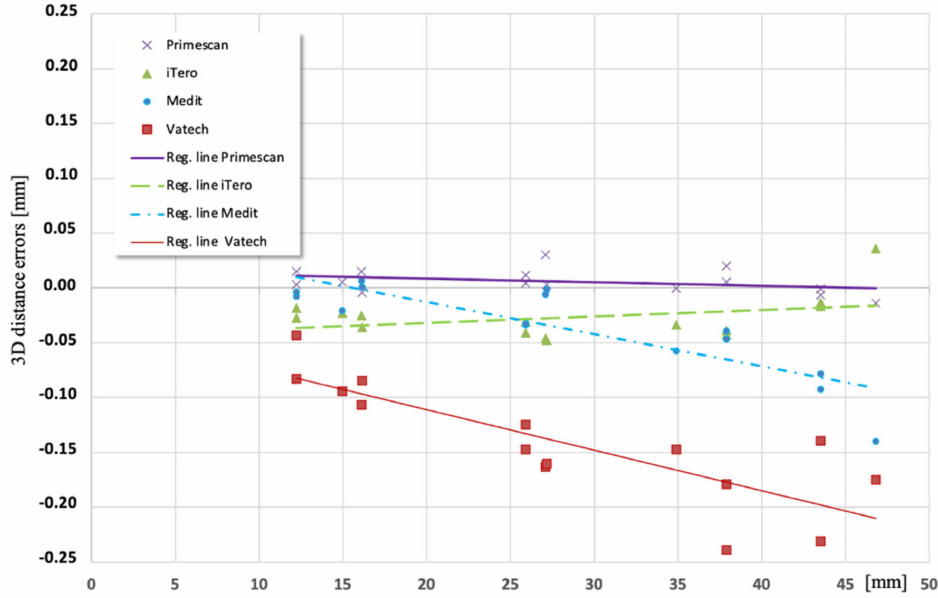
Figure 2. 3D distance errors: distance errors [mm] vs. inter-abutment distance [mm] with regression line of errors for each